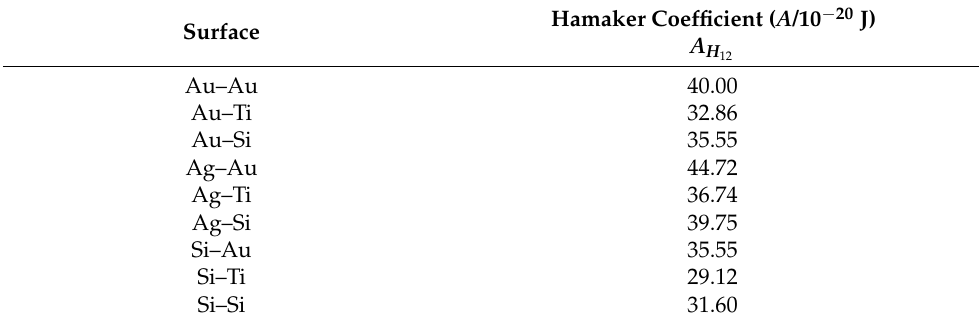
Table 4. Hamaker coefficients of surfaces.